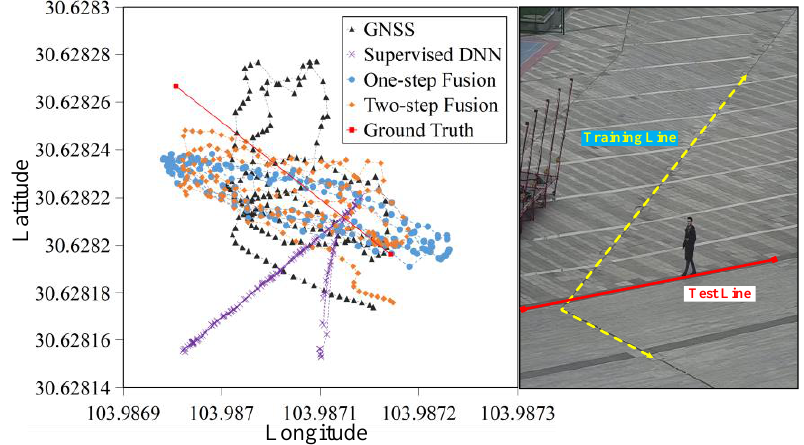
Figure 14. Generalization performance of methods.